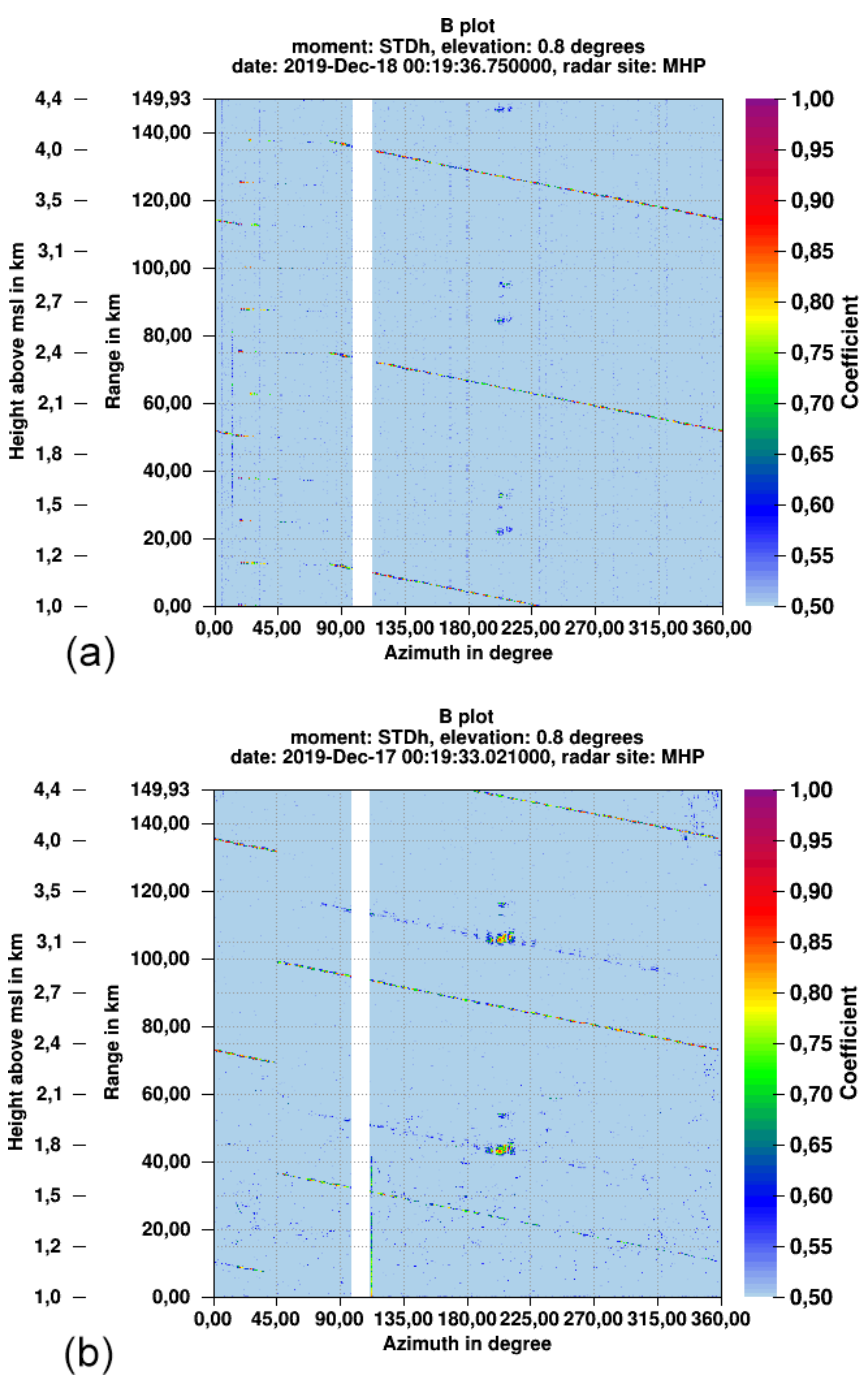
Figure 5. B plots of the normalized standard deviation of received power STDh (h denoting the horizontal receive channel) illustrating the interference from the Eisberg (EIS) radar (line shape structure). (a) Transmitter turned off, MHP radar only in receive mode. (b) MHP transmitter operating. At MHP, sector blanking is configured between 99 and 111 ◦ azimuth because of a church in the safety perimeter.